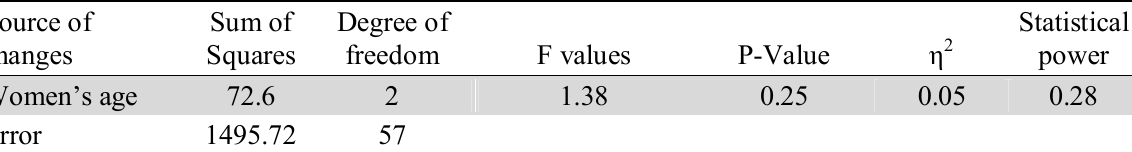
The results of surveying the relationship between women’s educational background and depression Source of changes